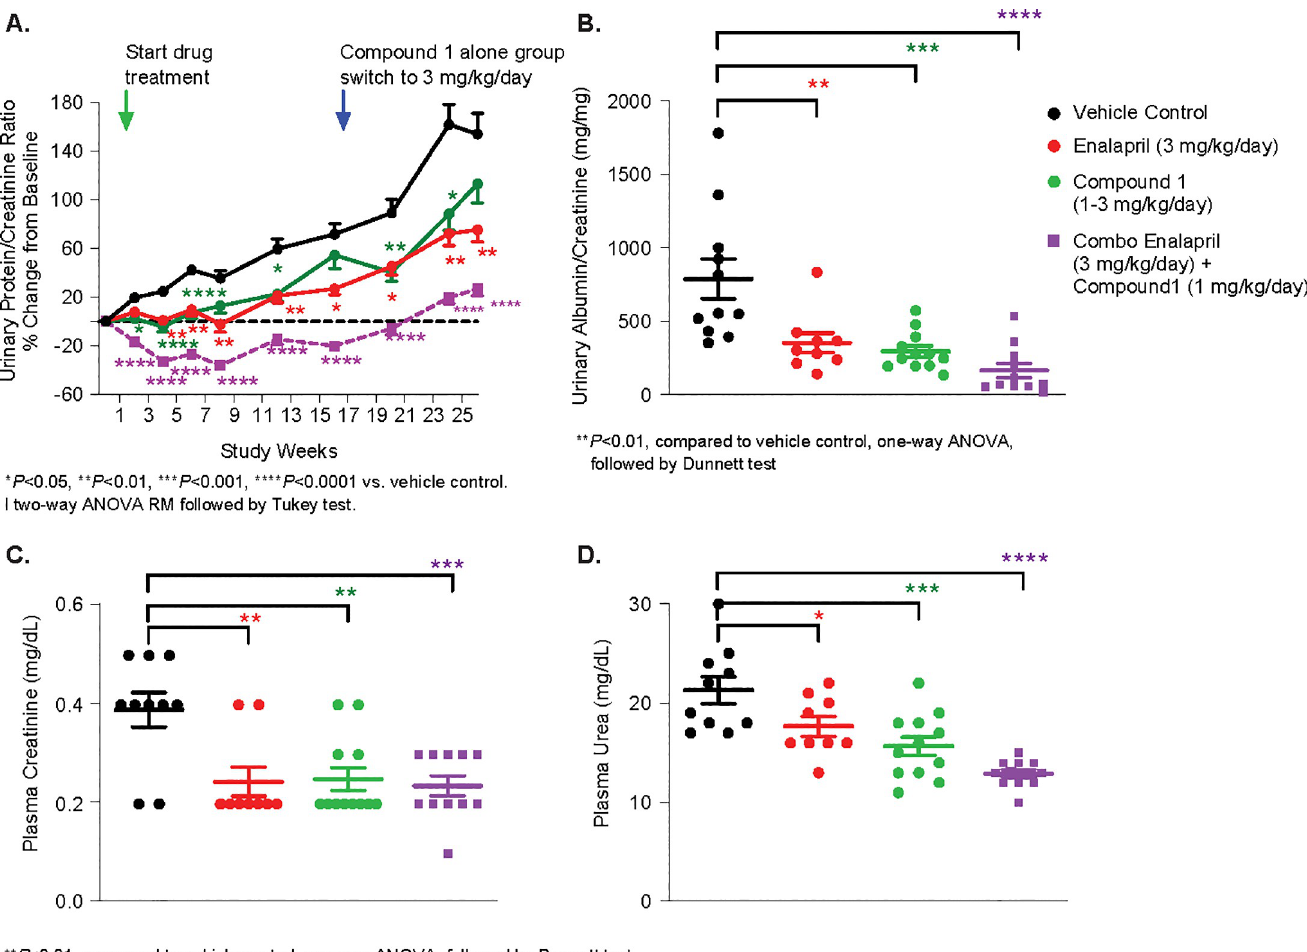
Fig 5. Effect of Compound 1 on urinary protein to creatinine ratio (UPCR). Green arrow indicates start of the treatments of Vehicle or Compound 1 or Enalapril or combination of Compound 1 and Enalapril for 6 months. Blue arrow indicates Compound 1 dose was switched from 1 mg/kg/day to 3 mg/kg/day. (A) Enalapril, Compound 1 and combination treatment significantly reduced protein to creatinine ratio compared to that of Vehicle control and (B) Albumin to creatinine ratio (UACR) at week 26. Enalapril, Compound 1 and combination of both significantly reduced albuminuria compared to that of Vehicle control. � P < 0.05, �� P < 0.01, ��� P < 0.001, ���� P < 0.0001 vs Vehicle control. Two-way repeated measures ANOVA followed by Tukey test. Effect of Compound 1 on plasma creatinine and urea. Plasma levels of creatinine (5C) and urea (5D) were significantly reduced in all 3 treatment groups. �� P < 0.01, compared to Vehicle control, one-way ANOVA, followed by Dunnett’s